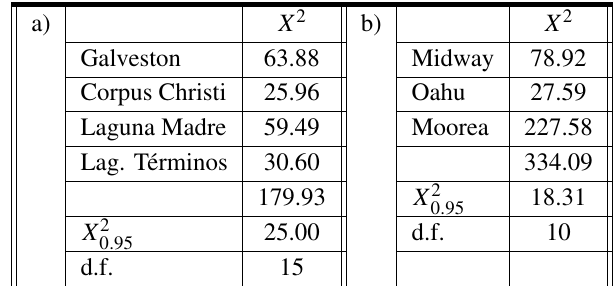
Chi-squared values (X 2 ) for the between-group comparison of (a) Bottlenose and (b) Spinner Dolphin